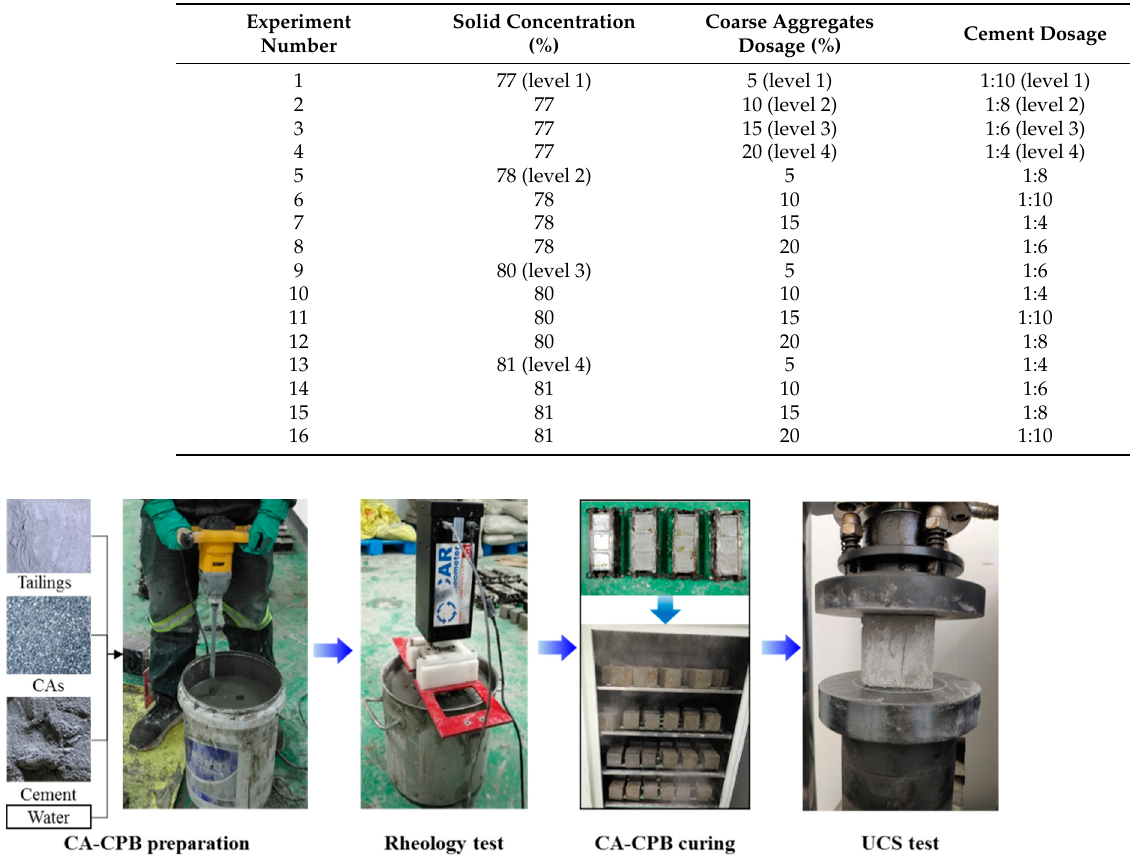
Figure 2. Test procedure.